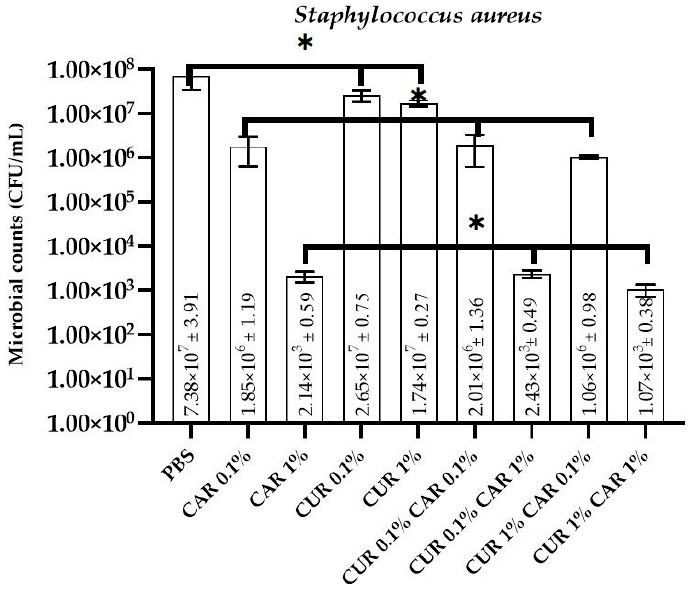
Figure 2. The effect of PBS-based neat and modified films on the viability of Staphylococcus aureus cells; one-way ANOVA: *— p > 0.05.